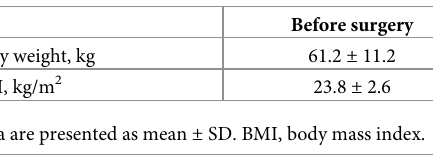
Table 5. Association between preoperative GHD and overweight and postoperative GHD. Postoperative GH status P Severe GHD+(N = 31) Severe GHD-(N = 17) Preoperative GH status 0.001 Severe GHD+ (N = 30) 25 (83%) 5 (17%) Severe GHD- (N = 18) 6 (33%) 12 (67%) Preoperative overweight < 0.001 Overweight (N = 15) 15 (100%) 0 (0%) Non-overweight (N = 33) 16 (48%) 17 (52%) GH, growth hormone; GHD, growth hormone deficiency.